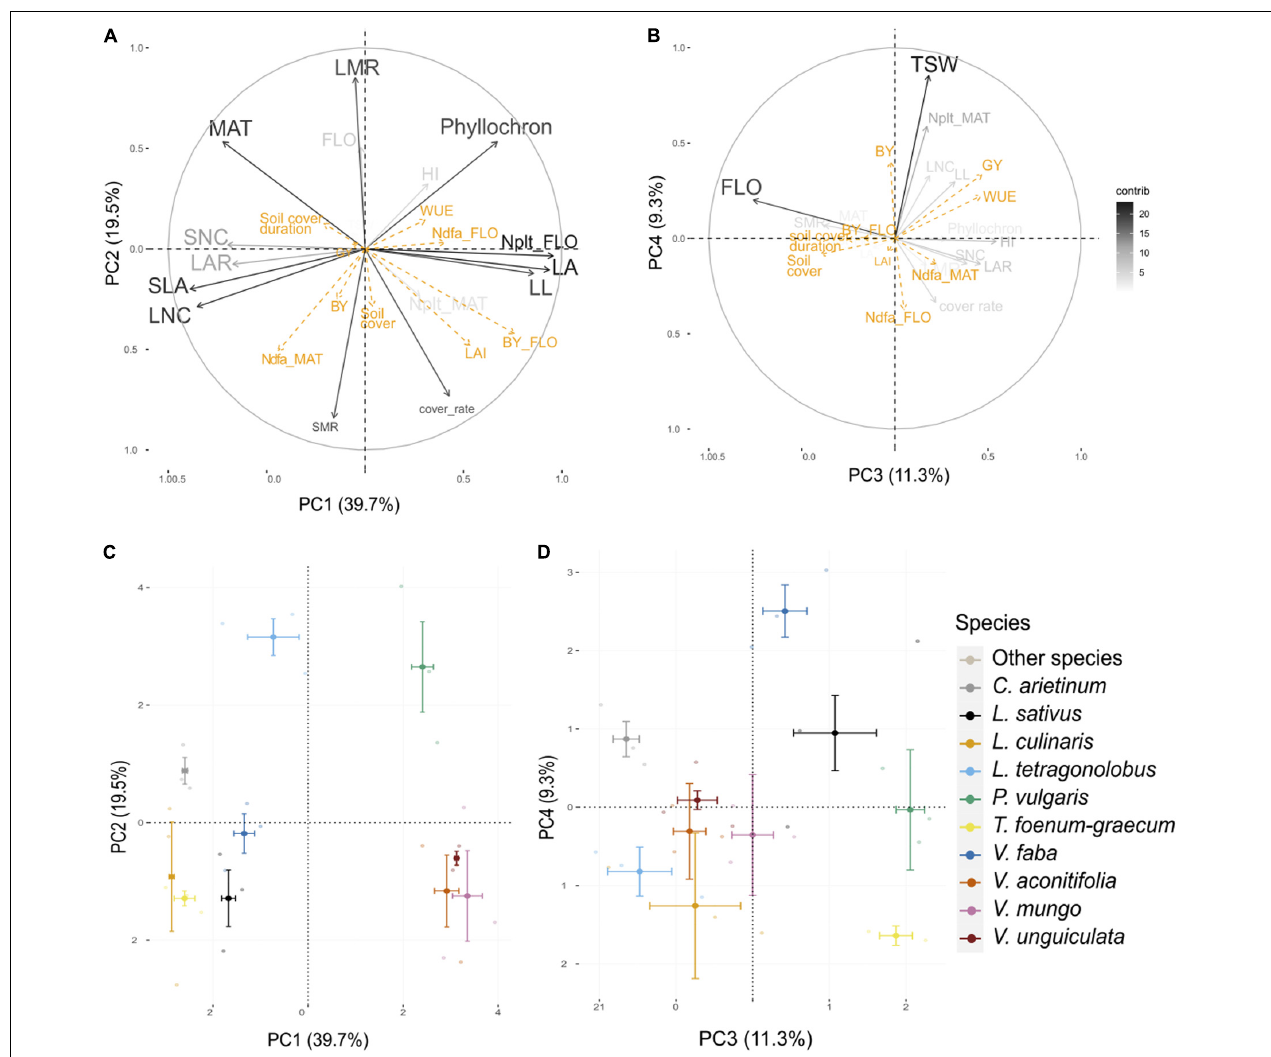
FIGURE 2 | Principal component analysis (PCA) performed on traits measured on three varieties of 10 species. Visualization of the variables and correlation circles on (A,C) PC1–PC2 and (B,D) PC3–PC4 planes. Gray scale represents the contribution of each variable to axes construction. Orange variables are agroecosystem properties, used as supplementary variables. See Table 2 for abbreviations of traits and properties. Soil cover stands for maximal soil